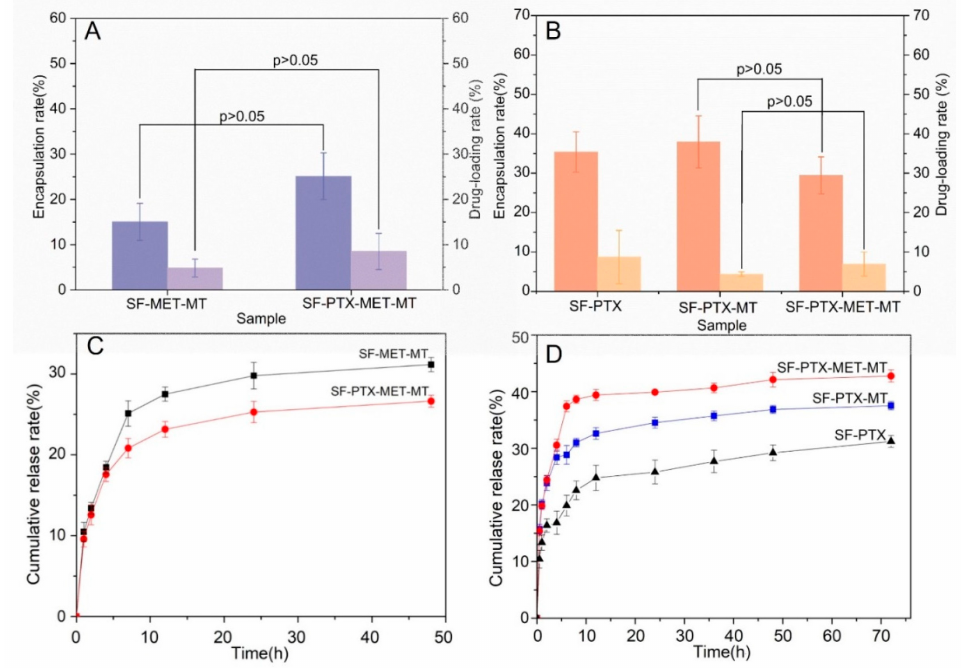
Figure 4. Quantitative characterization and cumulative release rate of drug-loaded SF microspheres prepared with different parameters: ( A ) MET; ( B ) PTX; ( C ) MET in vitro sustained release curve; ( D ) PTX in vitro sustained release